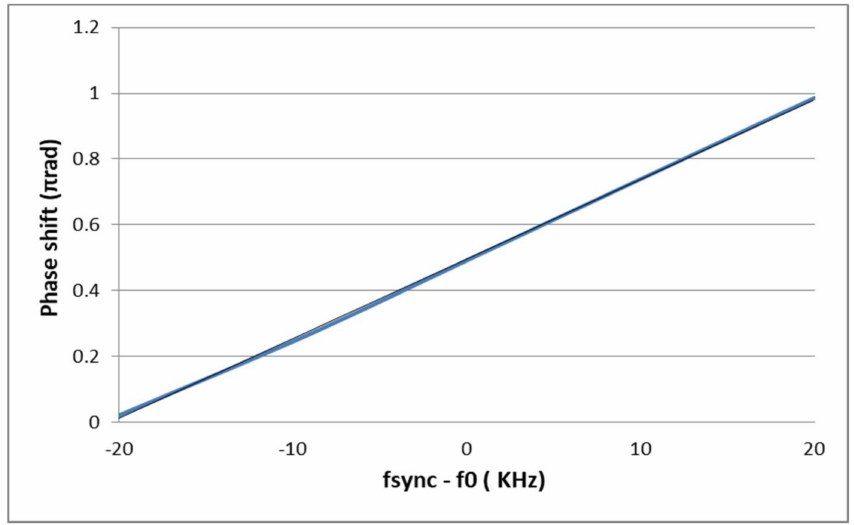
Figure 6. Simulation of the phase shift of the Injection Locked Relaxation Oscillator vs ( f sync − f 0